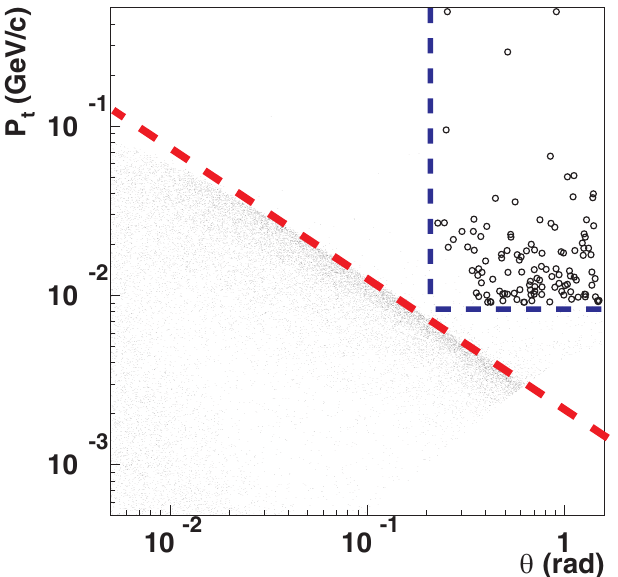
FIG. 7. (Color) Distribution of P versus (cid:1) for electrons from t IPC processes. The region corresponding to particles reaching the VD (circles) is indicated with the two dashed lines for the detector configuration described in the text. A thick dotted line highlights the edge of the beam-beam deflection induced accu- mulation